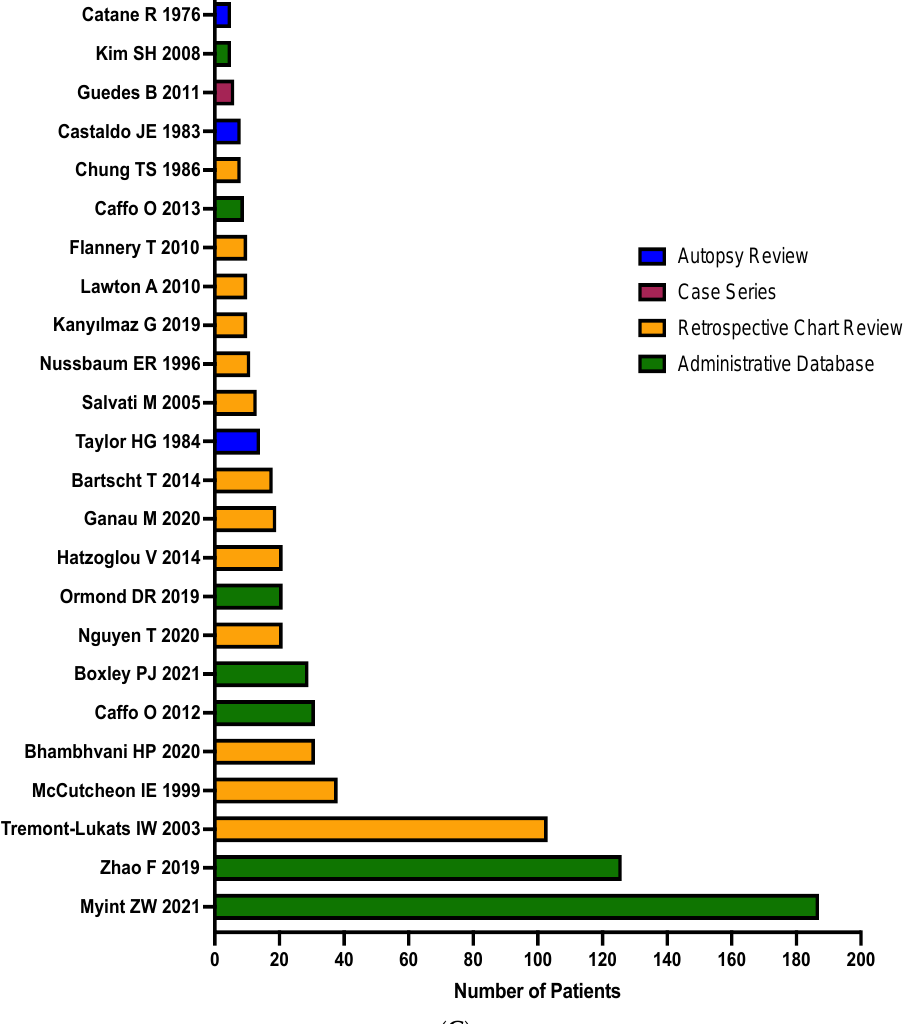
Figure 2. ( A – C ) Publication characteristics: the selected articles were analyzed to understand the characteristics regarding the country of study, temporal publication trends, as well as the number of patients per study and source of patient information. ( A ) Publication by country of study: number of publications by country of study. ( B ) Publication by year: depiction of the number of publications per five-year intervals. ( C ) Publication by patient selection : number of patients per study and assignment of publications to the following sources of information: autopsy reviews, case series, retrospective chart reviews, or administrative database search [4,5,7,9 – 14,30 – 47].